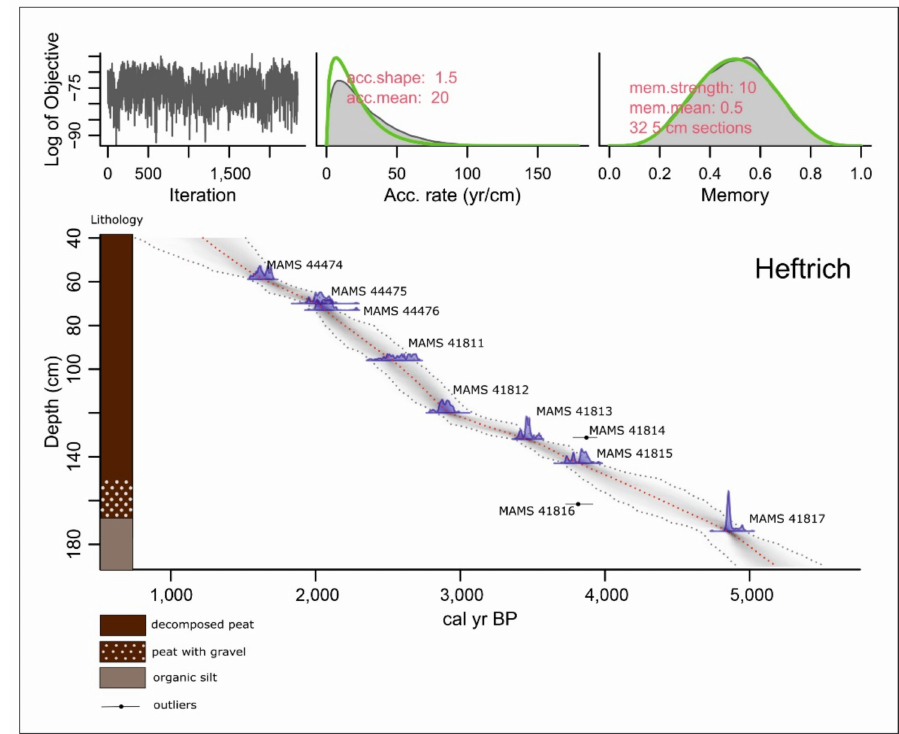
Figure 3. Age-depth model of profile